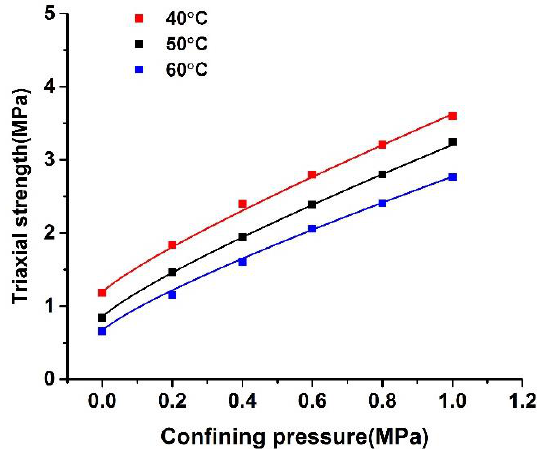
Figure 7. Triaxial results of OGFC-13 asphalt mixture.